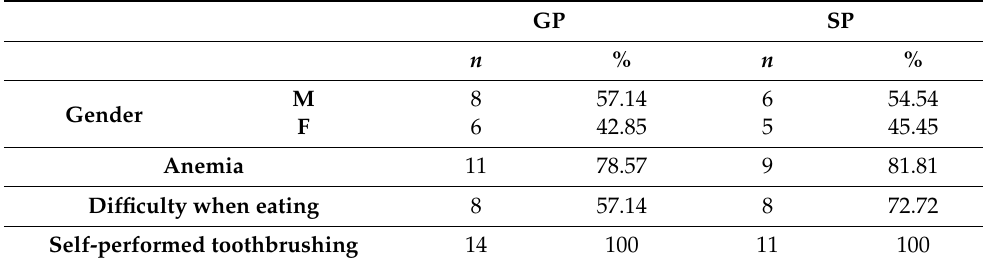
Table 1. Patient